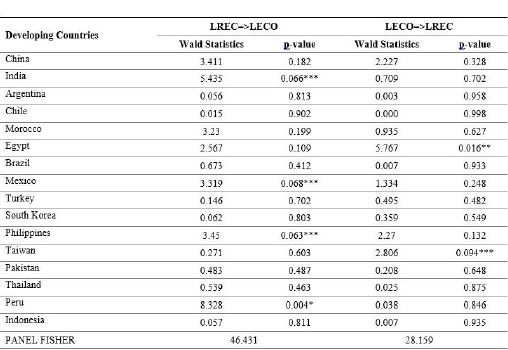
Table 11: Emirmahmutoğlu and Köse Panel Causality Test Analysis